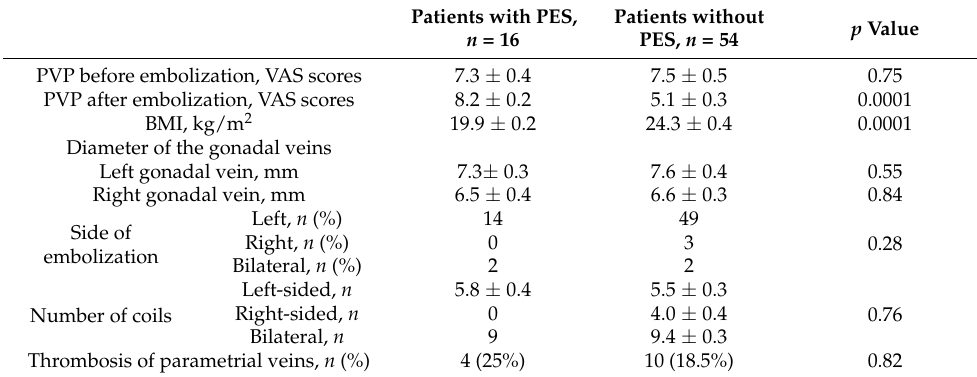
Table 3. Comparison between patients with and without PES development ( n =